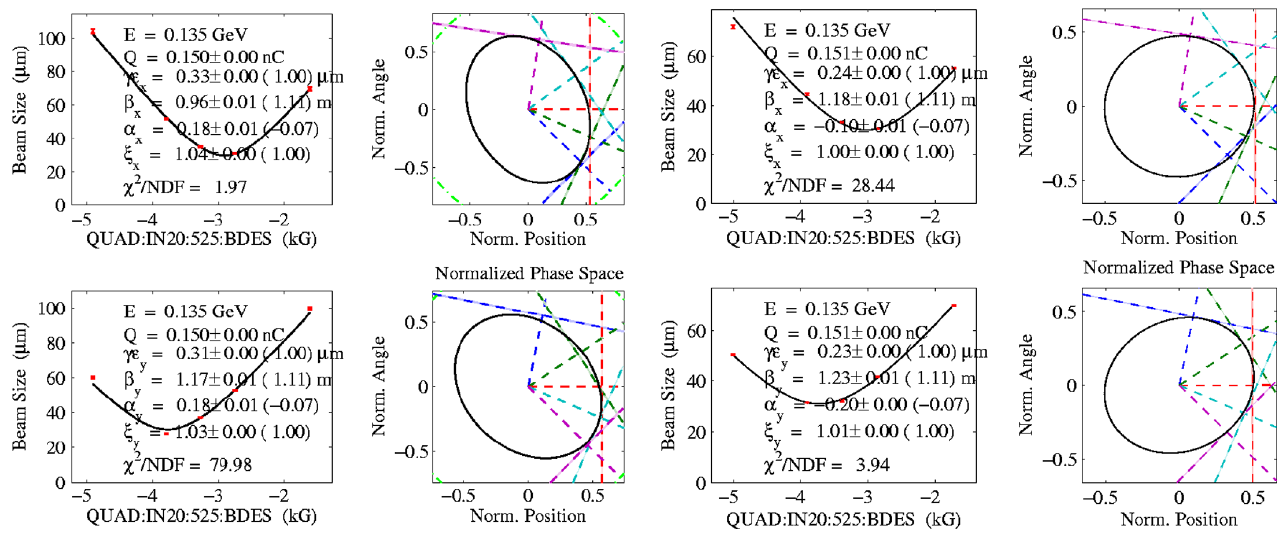
FIG. 6. Measured projected emittance at the LCLS injector with 150 pC: regular nearly uniform (left) and truncated-Gaussian (right) laser spatial distributions at the photocathode. Note that 5% of particles in the tails are excluded in the beam size